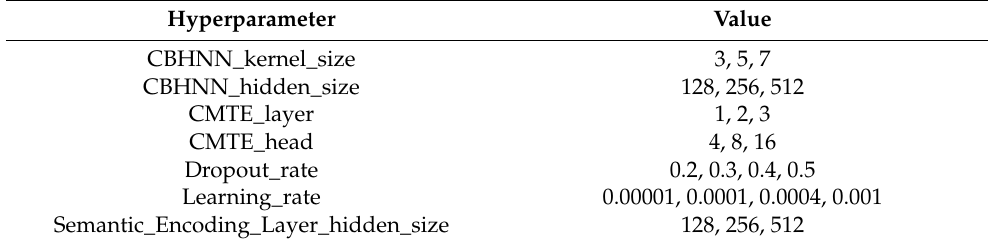
Table 2. The selection range of hyperparameters.